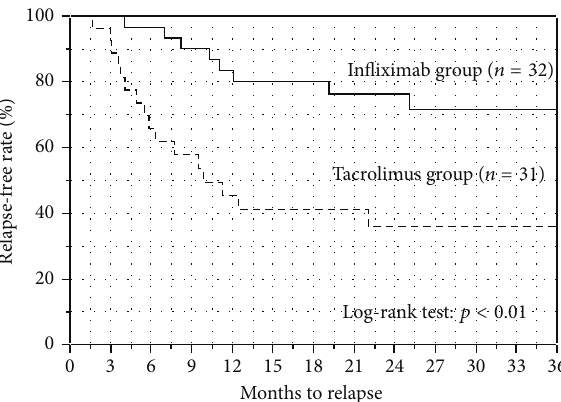
Figure 5: Kaplan-Meier plots for relapse-free survival (excluding 5 thiopurine-intolerant cases from the Tac group). Even though the 5 thiopurine-intolerant cases were excluded from the Tac group, the relapse-free survival rate was still significantly higher in the IFX group than in the Tac group ( 𝑝 < 0.01 ; log-rank